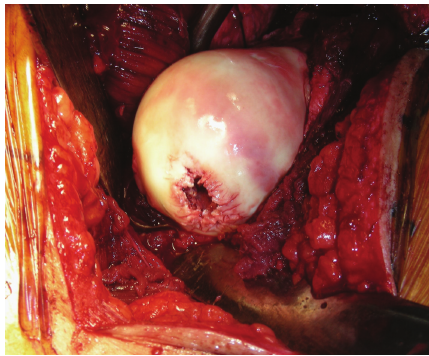
Figure 4: Intraoperative picture shows defect in femoral head after removal of bullet, prior to trimming and